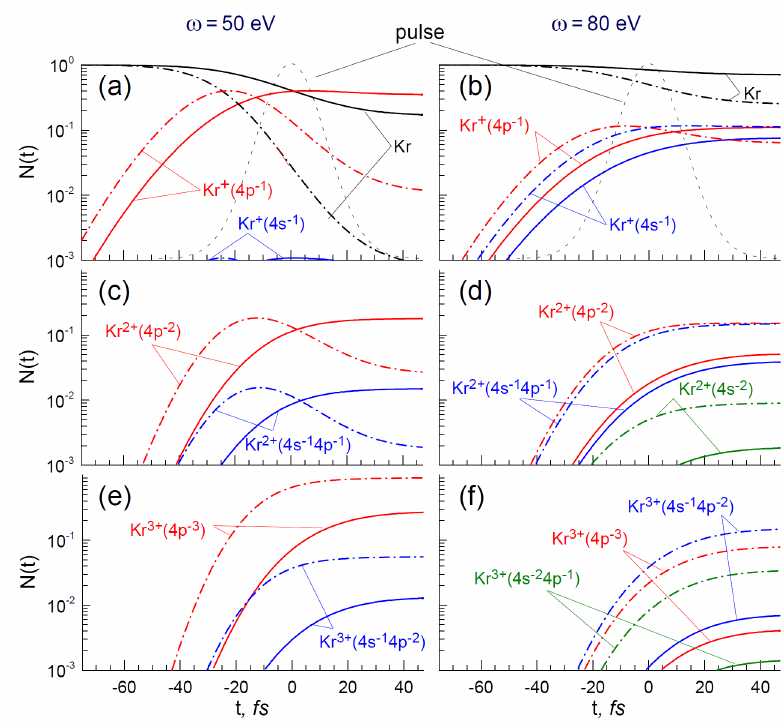
Figure 2. Population of different ion charge states and configurations for two fluences: F = 100 ph/Å 2 (solid lines) and F = 400 ph/Å 2 (dash-dotted line) for the photon energies 50 eV ( a , c , e ) and 80 eV ( b , d , f ). Black lines—ionization of neutral Kr; red lines—ionization to 4 s 2 4 p − n configuration, where n is the ion charge; blue lines—ionization to 4 s − 1 4 p − n + 1 , green lines—ionization to 4 s − 2 4 p − n + 2 . The pulse envelope (grey dashed line) is indicated in the upper panels.